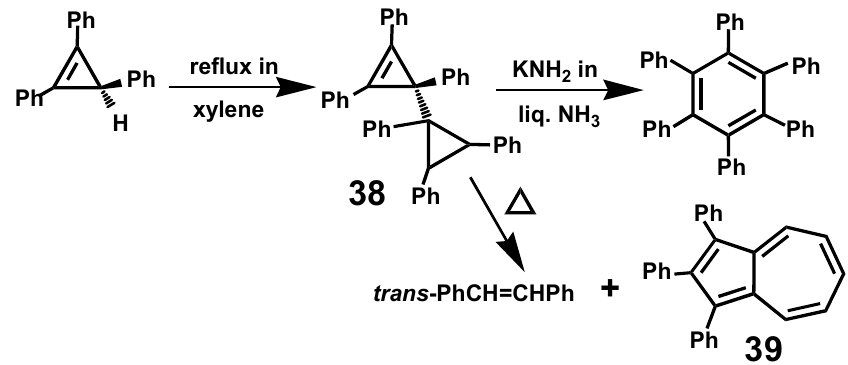
3-triphenylcyclopropyl-triphenylcyclopropene, 38 . Subsequent treatment with KNH 2 furnishes